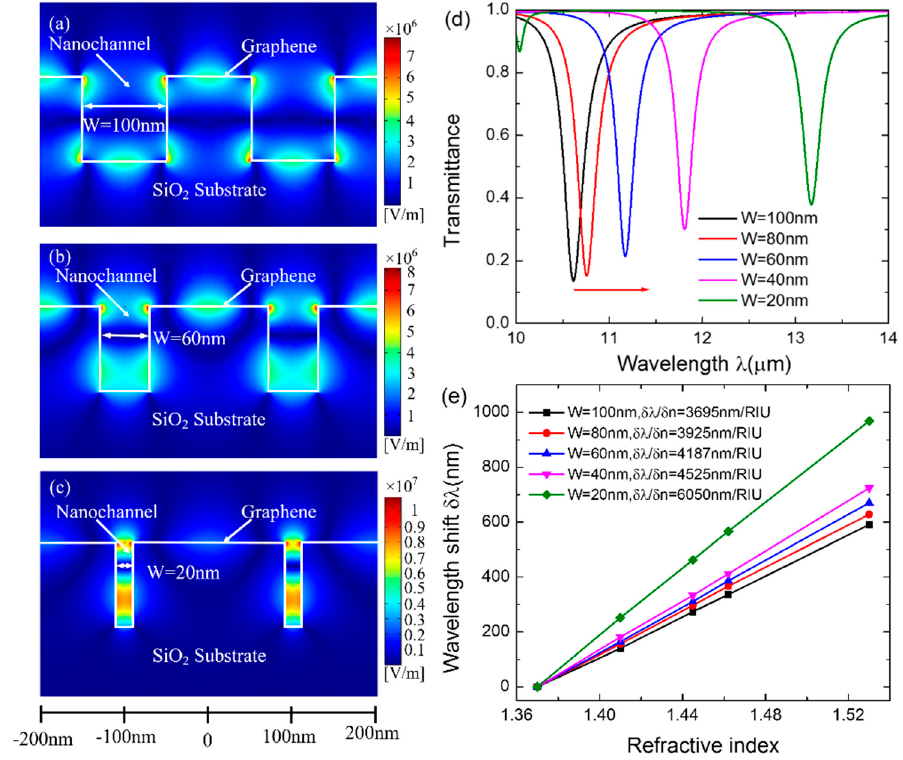
Figure 3. The GSP mode profiles when ( a ) W = 100 nm, ( b ) 60 nm, and ( c ) 20 nm in two periods. ( d ) Transmission spectra with decreasing W from 100 nm to 20 nm when Λ = 200 nm and H = 100 nm. ( e ) The calculated sensitivity when W = 100 nm, 80 nm, 60 nm, 40 nm, and 20 nm, respectively. The lines are linear fittings to the data.